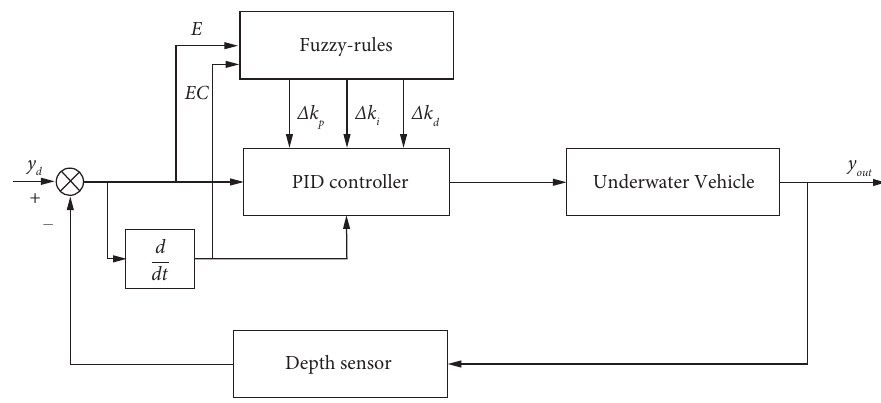
Figure 2: Fuzzy-PID control schematic